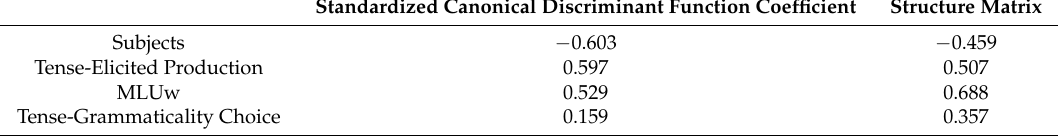
Table 7. Standardized canonical discriminant function coefficient and structure matrix for the discourse sensitive